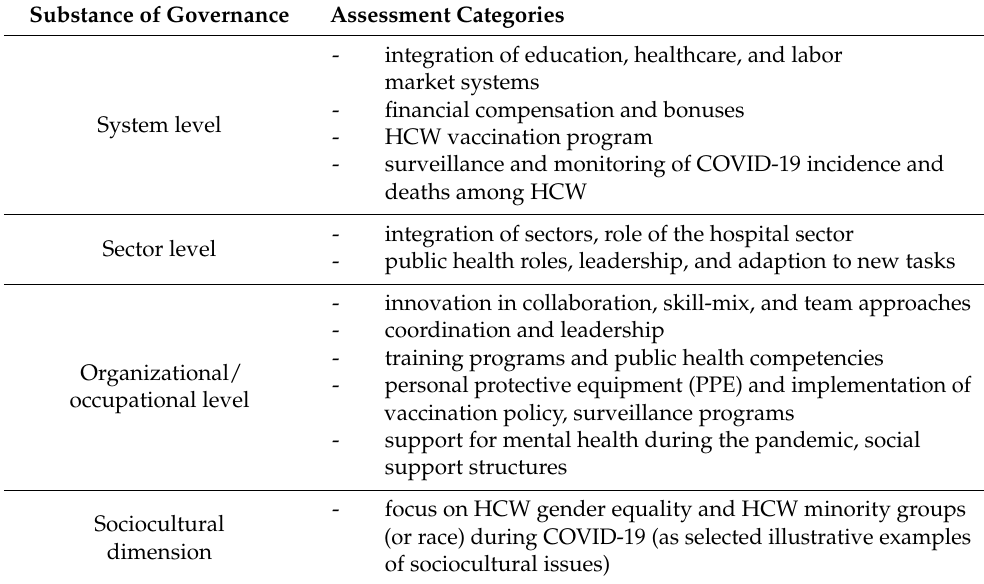
Table 1. A multi-level governance tool for comparing COVID-19 health workforce policy.